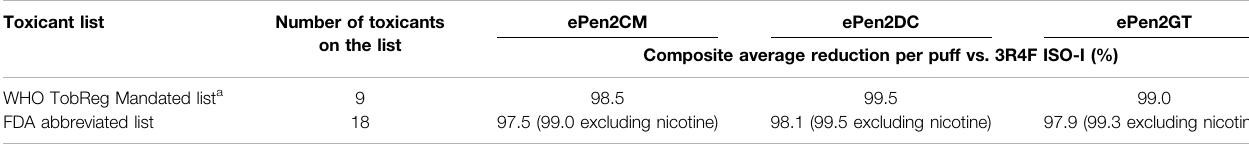
TABLE 6 | Composite percentage reductions in yields from the ePen2 variants vs. the 3R4F smoked under ISO-I for toxicants listed by WHO TobReg and Health Canada. Toxicant list Number of toxicants on the